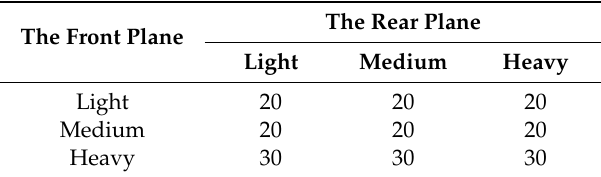
Table 2. Surface taxi, aircraft time vortex separation